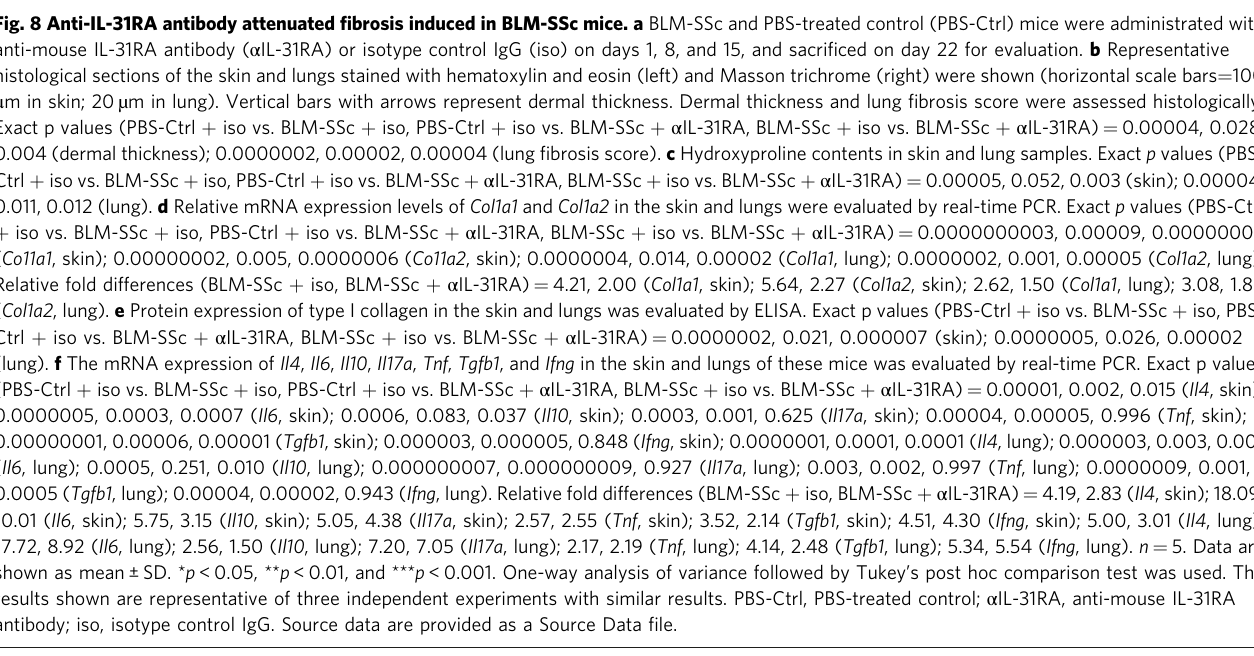
results shown are representative of three independent experiments with similar results. PBS-Ctrl, PBS-treated control; α IL-31RA, anti-mouse IL-31RA antibody; iso, isotype control IgG. Source data are provided as a Source Data fi